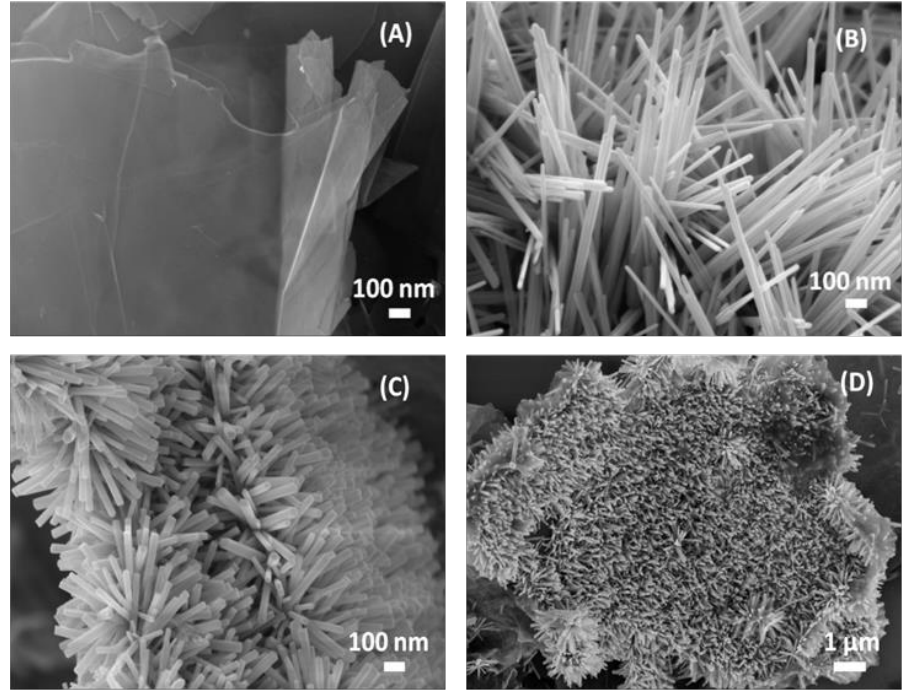
Figure 1. Field emission scanning electron microscopy (FE-SEM) images of ( A ) pristine graphene nanoplatelets (GNPs), ( B ) pristine zinc oxide nanorods (ZnO-NRs), and ( C , D ) ZnO-NRs-decorated GNPs (ZNGs).